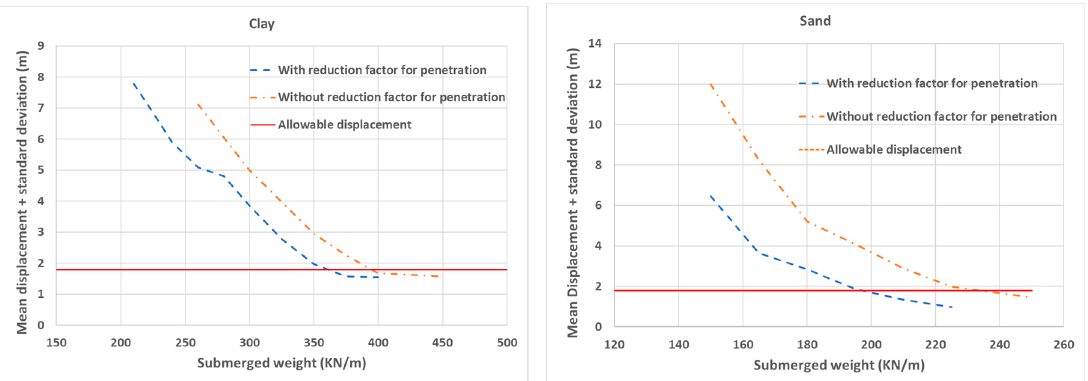
Figure 5. The lateral displacement of the umbilical for seven wave realizations and the mean and standard deviation of lateral displacement (cases without reduction factor).